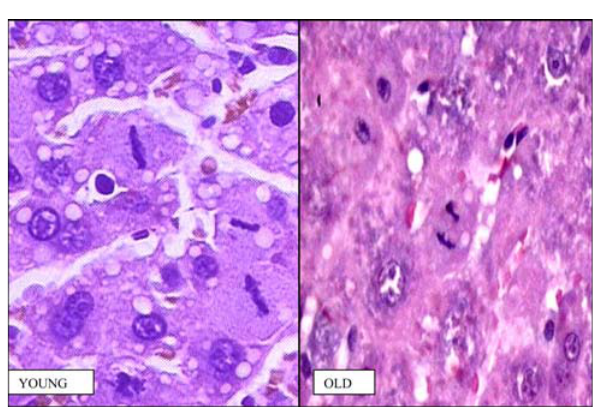
FIGURE 3 - Photomicrographs of histological liver cuts after 24 hours. Cellular division can be observed (HE – 1000 X)